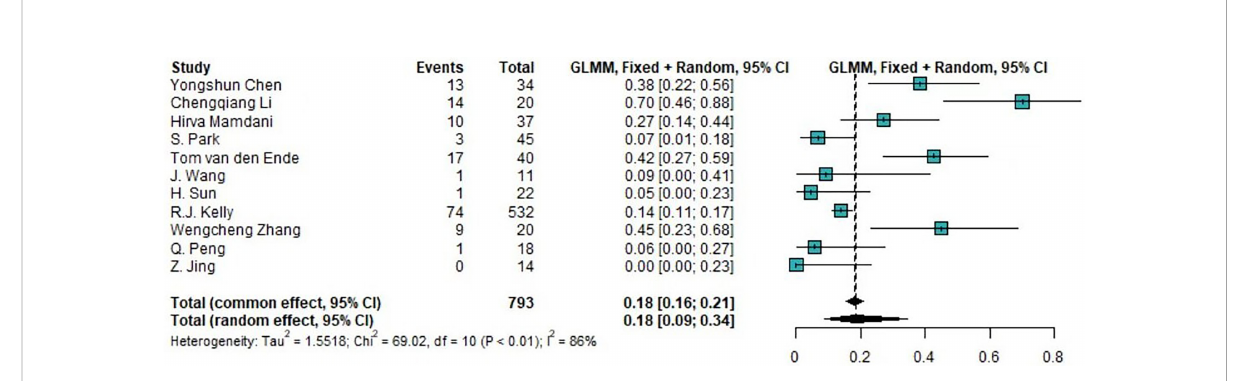
FIGURE 3 Forest plot of the incidence of high-grade treatment-related AEs. AEs, adverse events; GLMM, generalized linear mixed